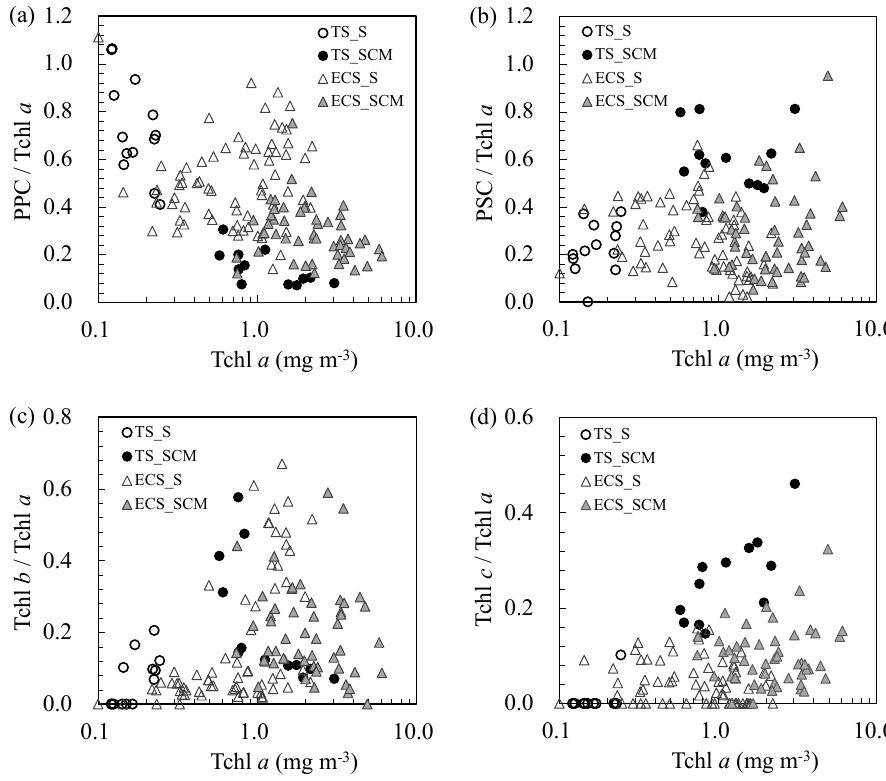
Fig. 7. Variations in the ratios of PPC (a) , PSC (b) , Tchl b (c) , and Tchl c (d) to Tchl a as a function of Tchl a in the Tsushima Strait surface (TS_S), Tsushima Strait SCM (TS_SCM), East China Sea surface (ECS_S) and East China Sea SCM (ECS_SCM).